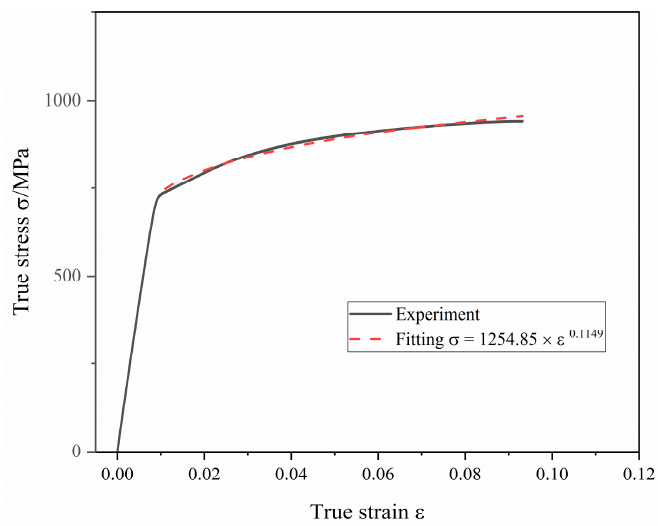
Figure 4. True stress–strain curve and hardening fitting of titanium tube.